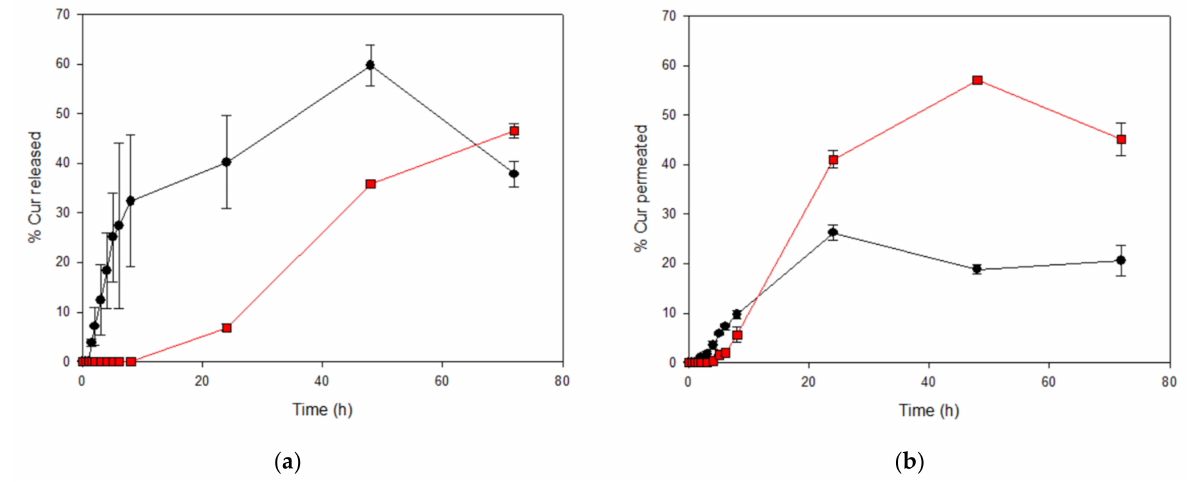
Figure 5. Percentage of Curcumin released ( a ) and permeated ( b ) from the optimized hydrogel (CurEpi β CD-Gel ) and CurEpi β CD solution (CurEpi β CD-Sol